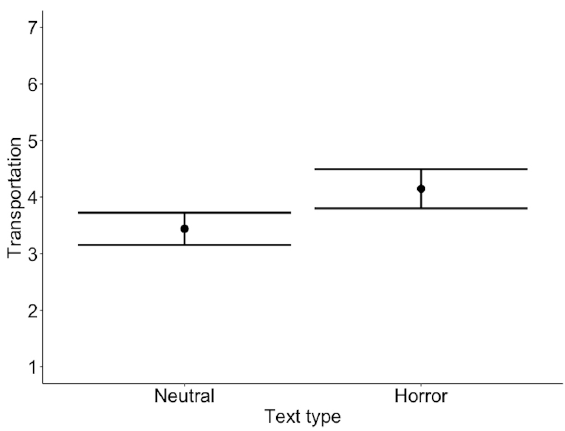
Figure 4. Model estimates for transportation ratings. Error bars represent 95% confidence